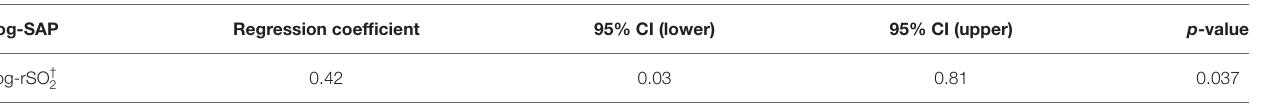
TABLE 2B | Regression coefficients with SAP and rSO 2 .